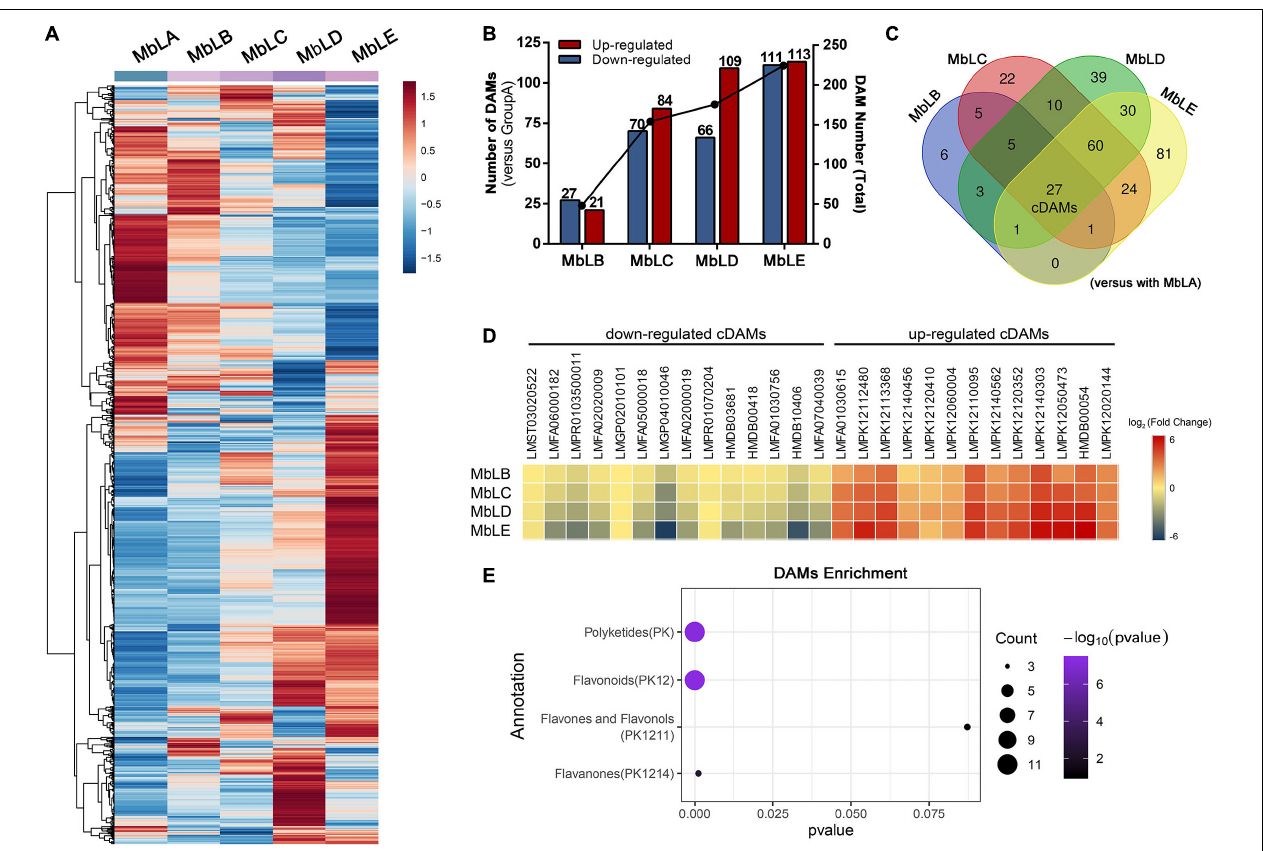
FIGURE 2 | Differential metabolite accumulation in the mulberry leaves at different periods. (A) Heat map of all metabolites for MbLA to MbLE. (B) The changes of the significantly differentially accumulated metabolites (DAMs) at different periods. (C) Venn diagram for all DAMs in MbLB, MbLC, MbLD, and MbLE, with MbLA as the control group. cDAMs refers to common differential accumulation metabolites. (D) Heat map of the cDAMs in MbLB, MbLC, MbLD, and MbLE. (E) Metabolites annotation enrichment of upregulated cDAMs. The number of DAMs is represented by the circle